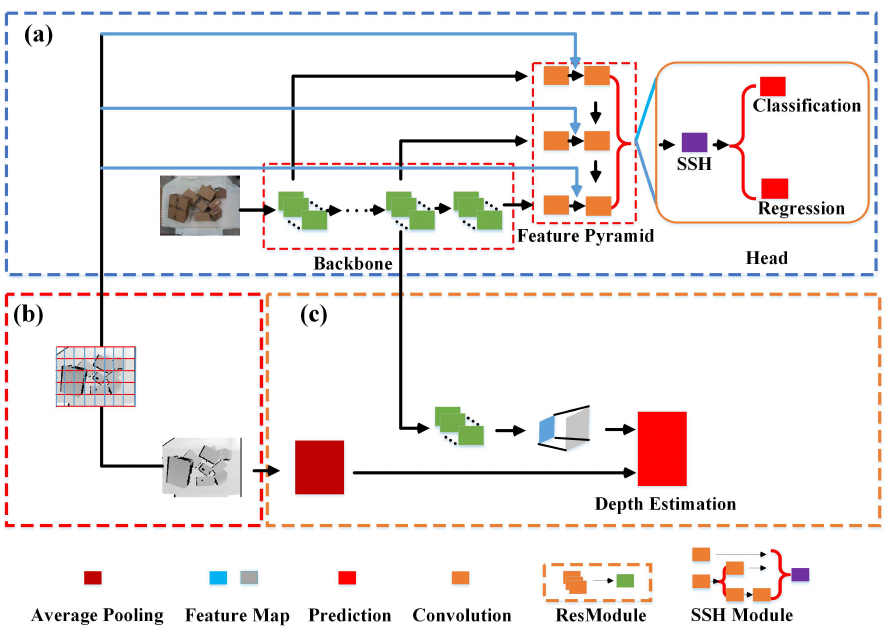
Figure 3. The overall system of OD-MF. ( a ) Modal’s architecture ( b ) Depth self-attention ( c ) Depth